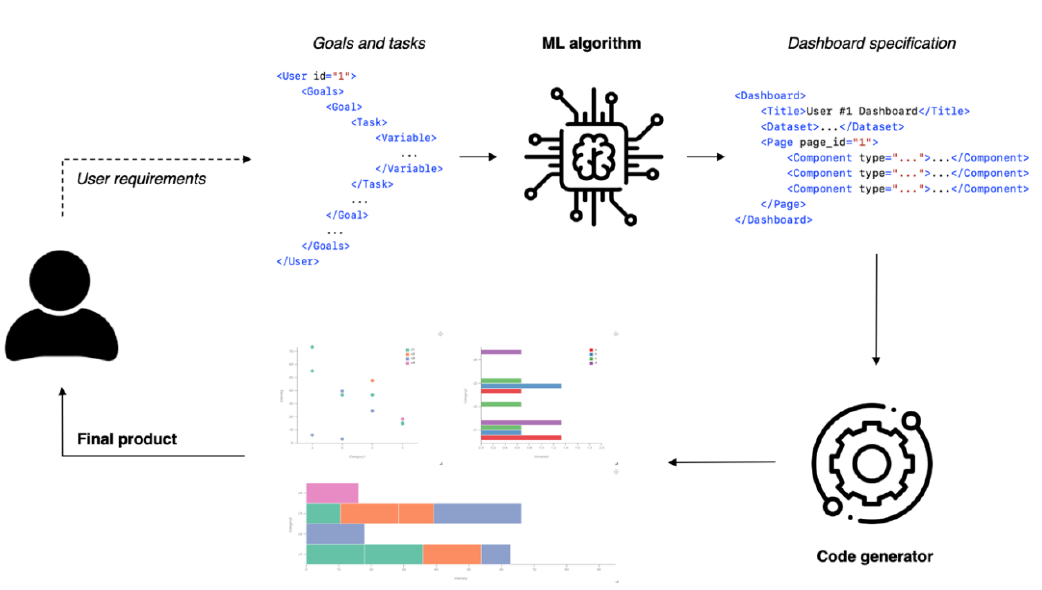
Figure 8. Generative pipeline proposal using the metamodel-based DSL. Icons made by Freepik (www.flaticon.com/authors/freepik).